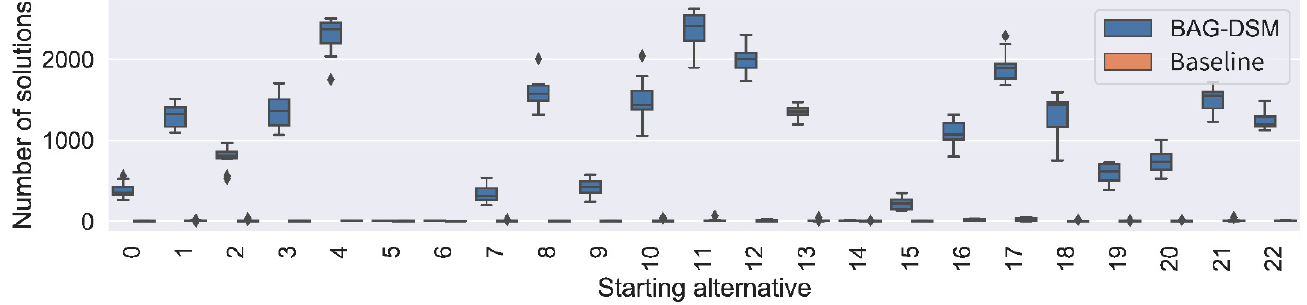
Figure 9. Boxplots for the size of the solution set (bigger is better) generated by BAG-DSM vs. baseline for the Landmark model.